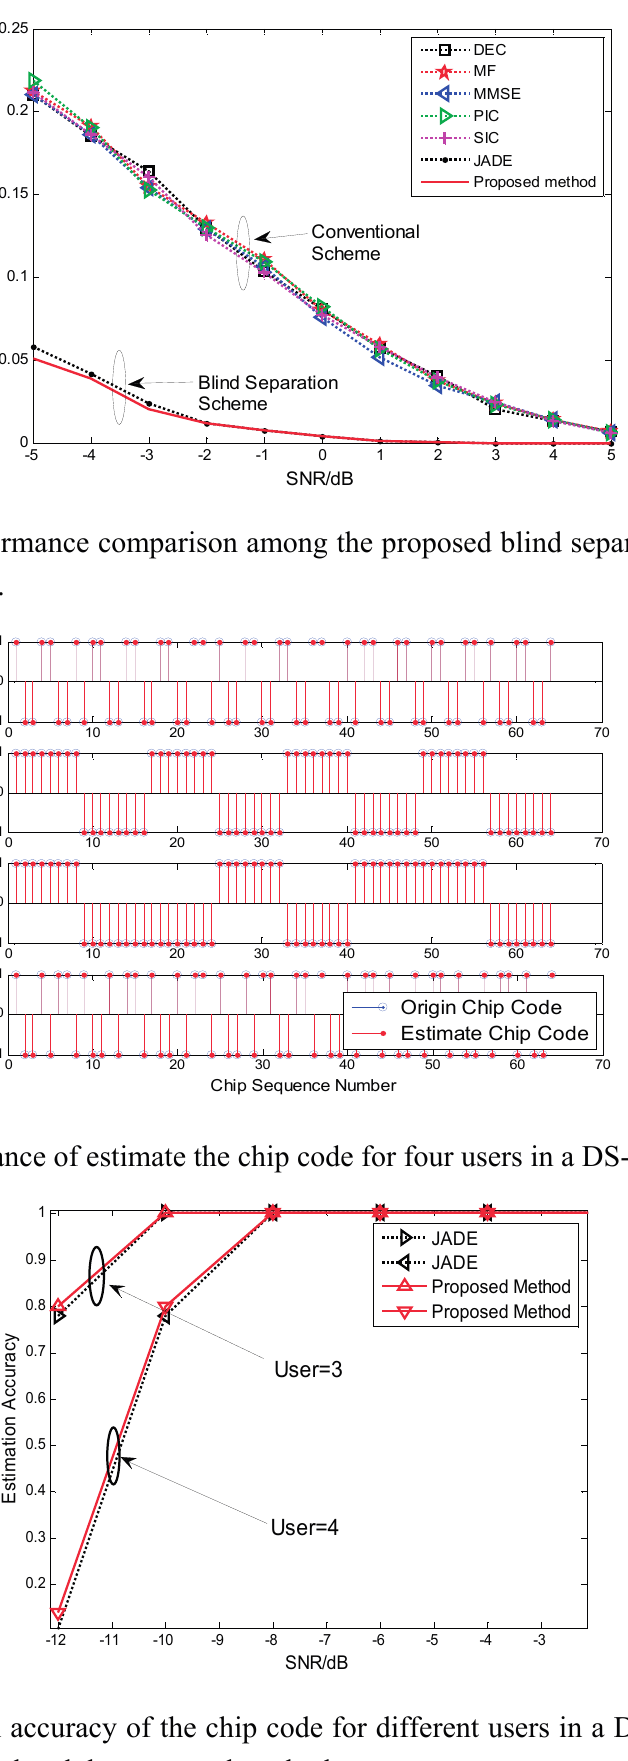
Figure 6. Estimation accuracy of the chip code for different users in a DS-CDMA system with the JADE method and the proposed